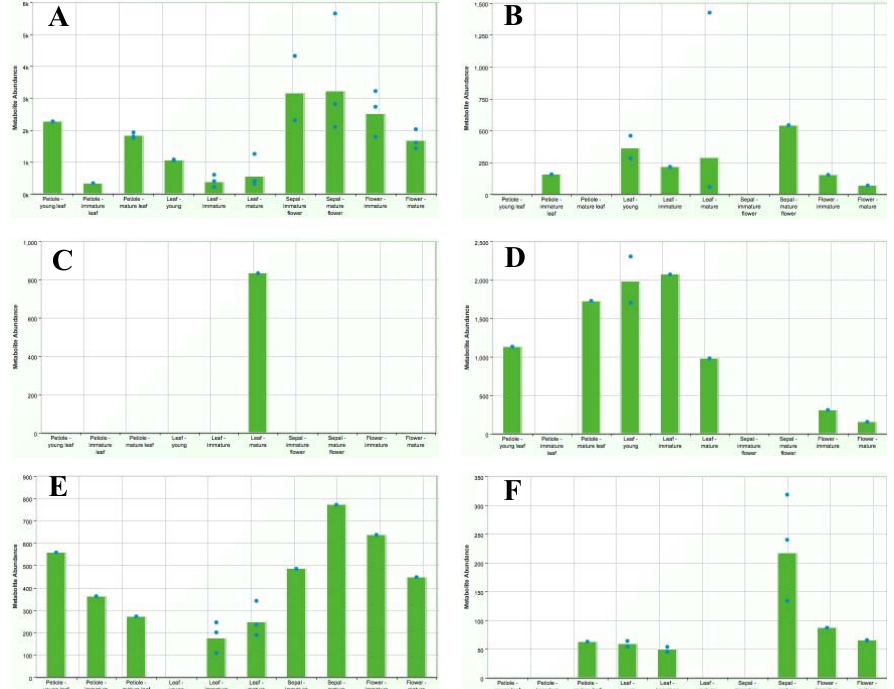
Figure 13. Levels of select cardenolides and putative biosynthetic intermediates in various tissues of Digitalis purpurea